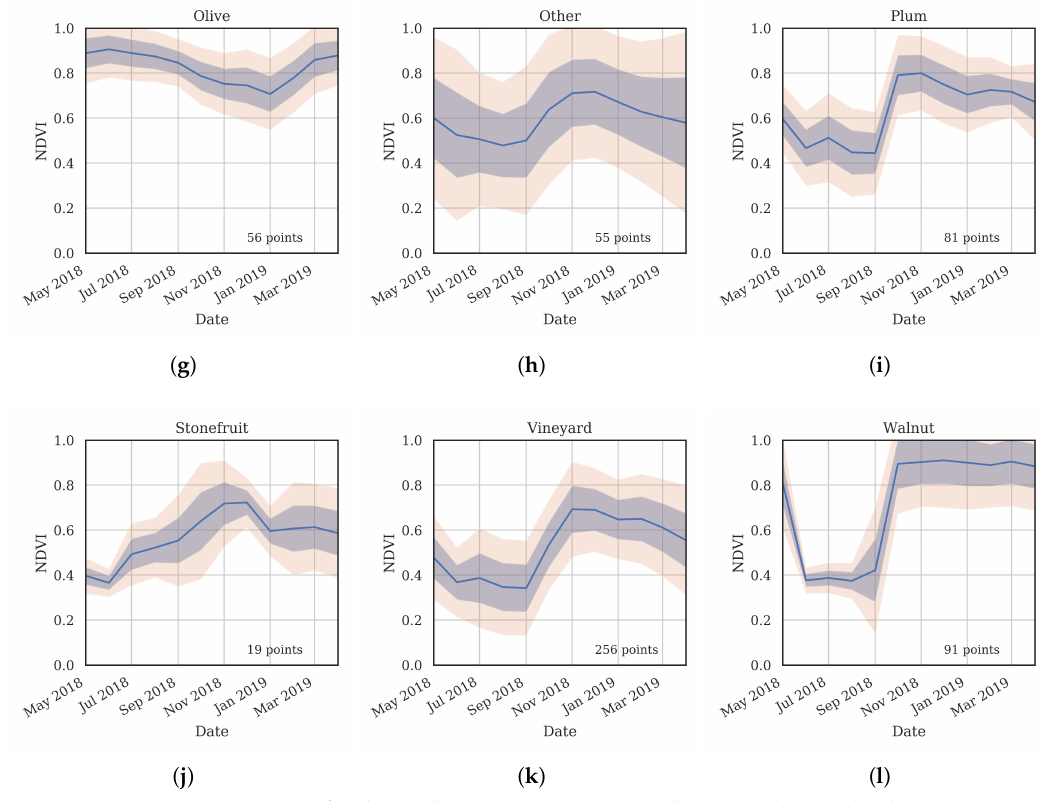
Figure 11. Time series NDVI for the 12 classes within K-means cluster 0. The graphs show the mean value for all training points per class, along with one and two standard deviations from the mean. The classes shown are: ( a ) Almond, ( b ) Annual, ( c ) Cherry, ( d ) Citrus, ( e ) Forest, ( f ) Hazelnut, ( g ) Olive, ( h ) Other, ( i ) Plum, ( j ) Stonefruit, ( k ) Vineyard and ( l )